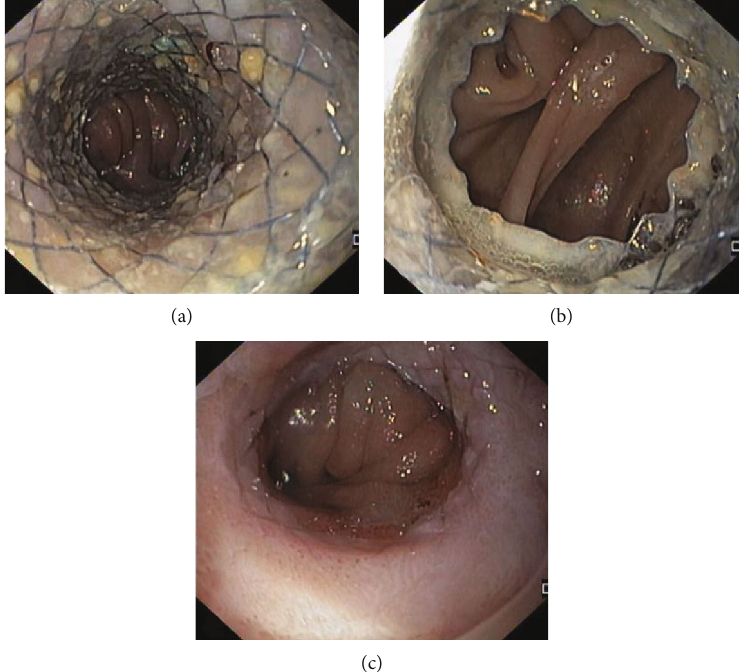
Figure 4: Patient with a refractory esophago-jejunal anastomotic stricture who underwent placement of lumen apposing metal stent (LAMS) across the stricture. (a, b) Endoscopic image of the LAMS placed across the stricture. (c) Esophago-jejunal anastomotic stricture remodelling after LAMS